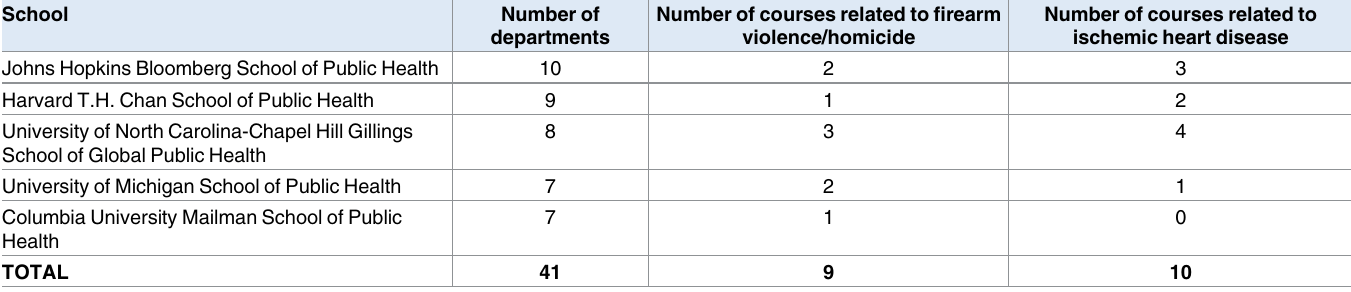
Table 2. Number of courses offered at the top five American schools of public health with mention of firearm violence/homicide in course